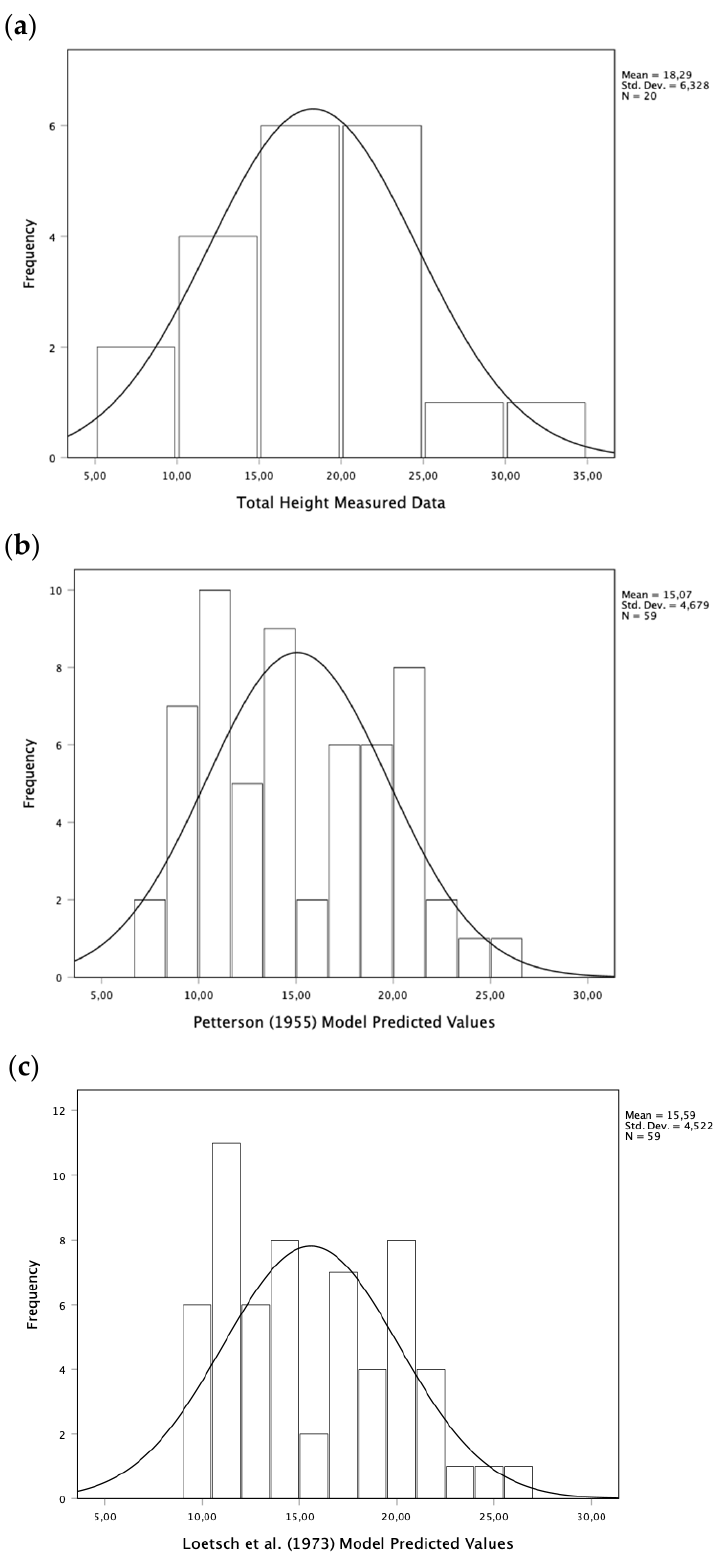
Figure 6. Histograms corresponding to the distribution of data ( a ) obtained by directly measuring the trees used in the construction of the models; ( b ) obtained by applying the model of Petterson (1955); and ( c ) obtained by applying the model by Loetsch et al. (1973).